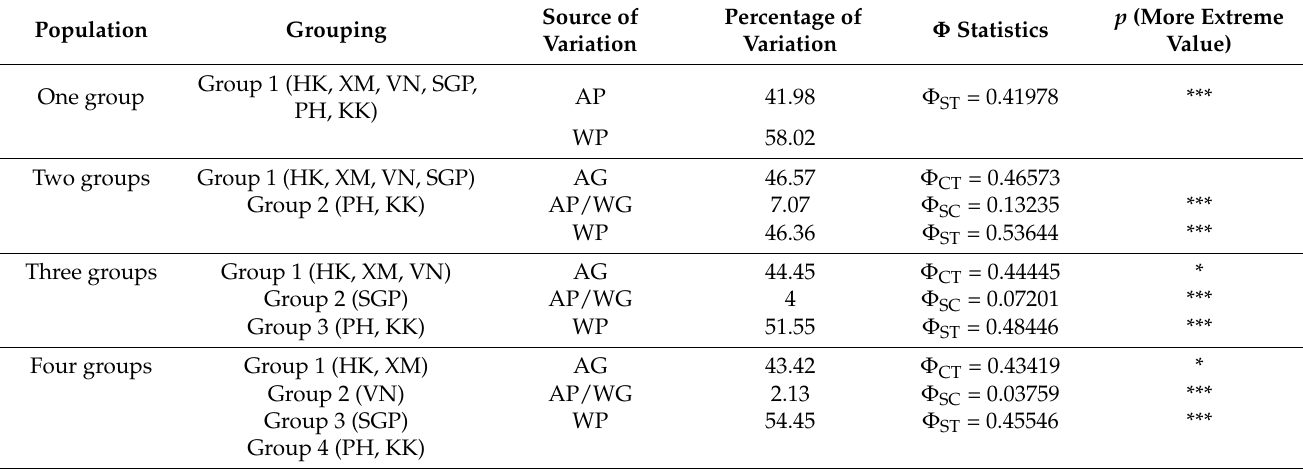
Table 3. AMOVA results for 6 populations of Portunus pelagicus in Southeast